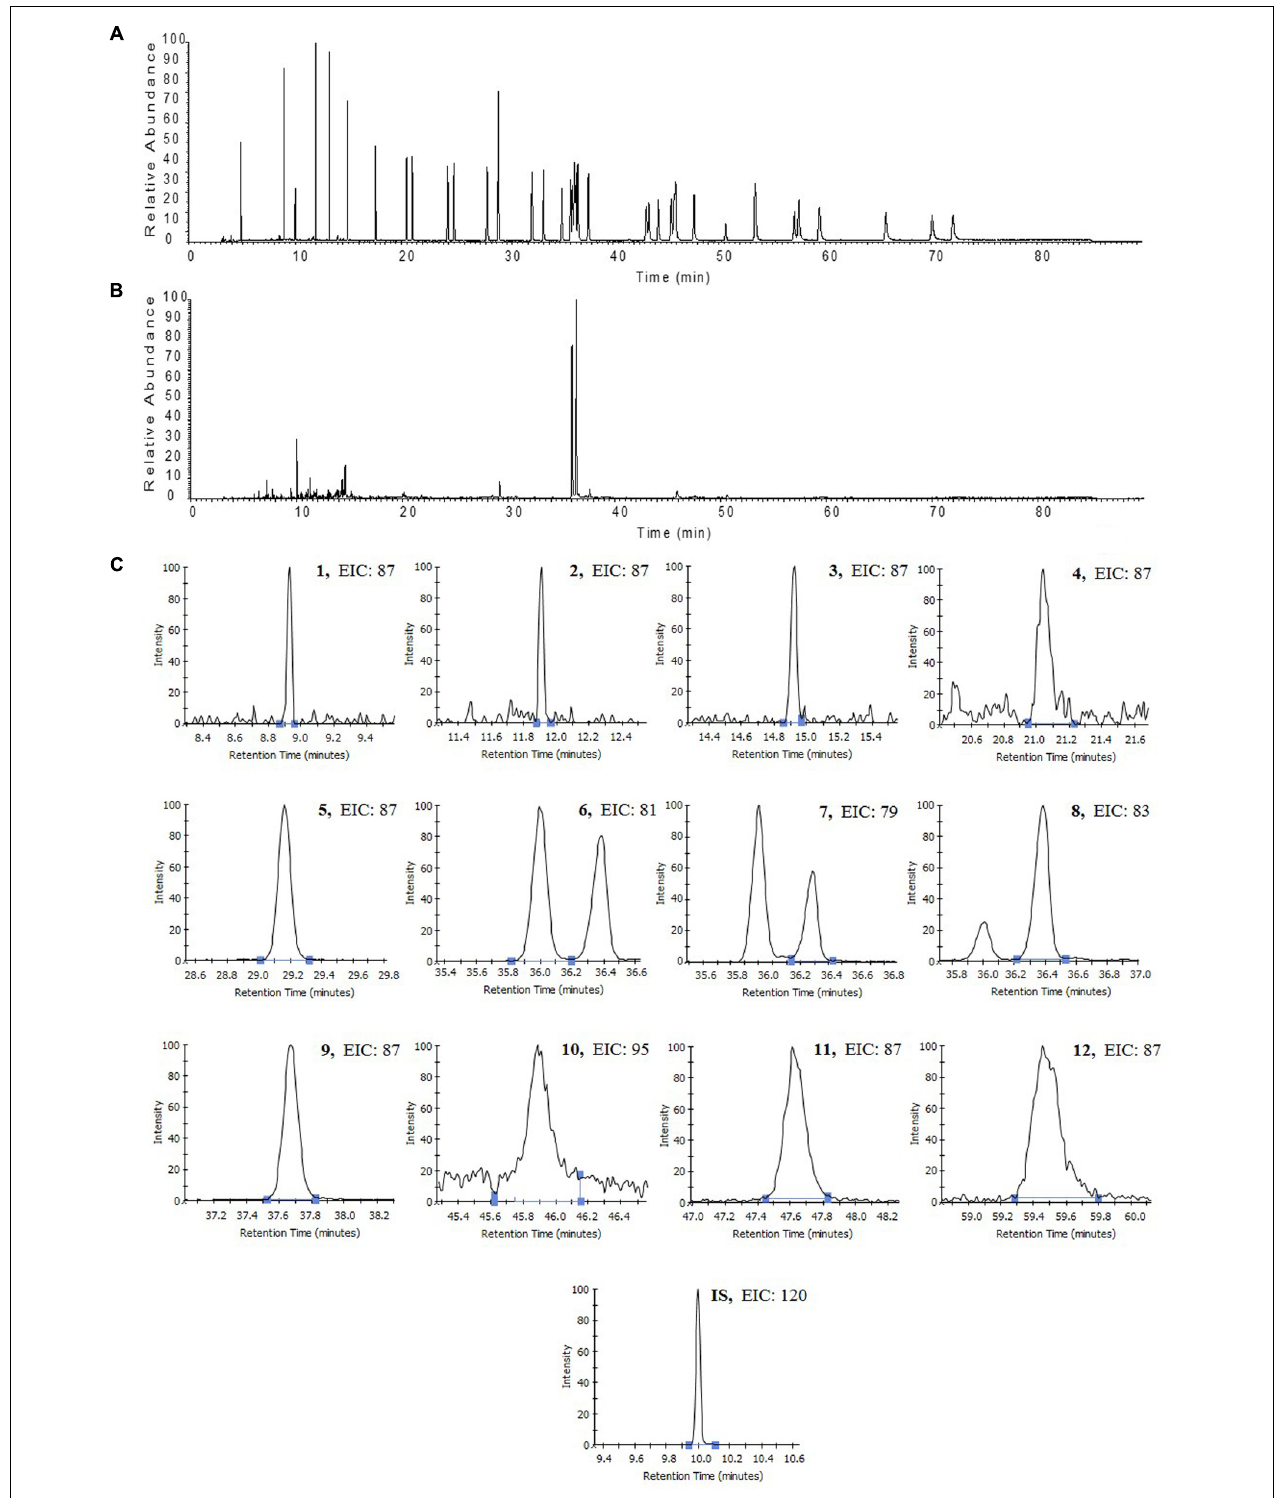
FIGURE 5 | Total ion chromatography of mixed standards (A) and sample (B) , and EIC chromatography of sample (C) for fatty acids analyzed with gas chromatography coupled with mass spectrometry (GC-MS) method. Octanoic acid (1), decanoic acid (2), dodecanoic acid (3), tridecanoic acid (4), palmitic acid (5), linoleic acid (6), linolenic acid (7), oleinic acid (8), stearic acid (9), eicosenoic acid (10), eicosanoic acid (11), docosanoic acid (12), methyl salicylate (IS).